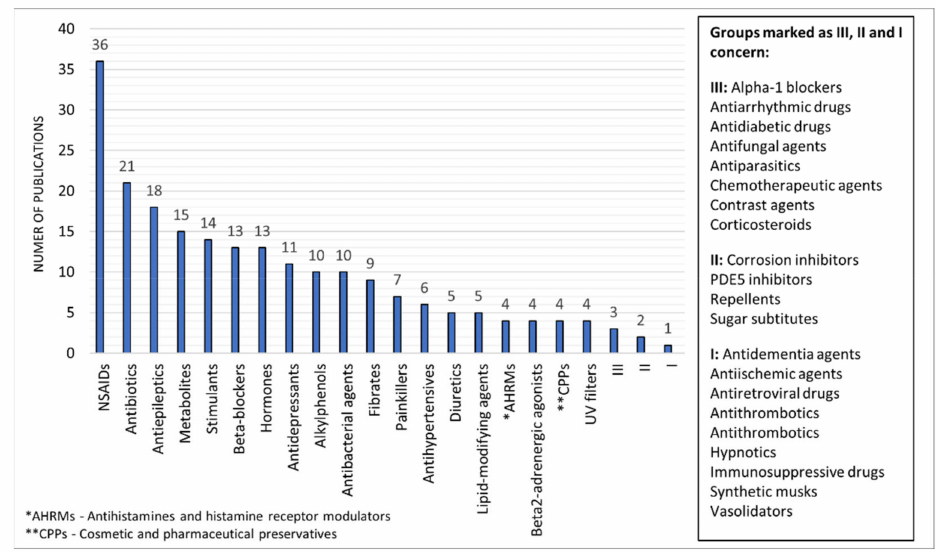
Figure 3. Number of publications of Polish research concerning compounds from the considered PPCP